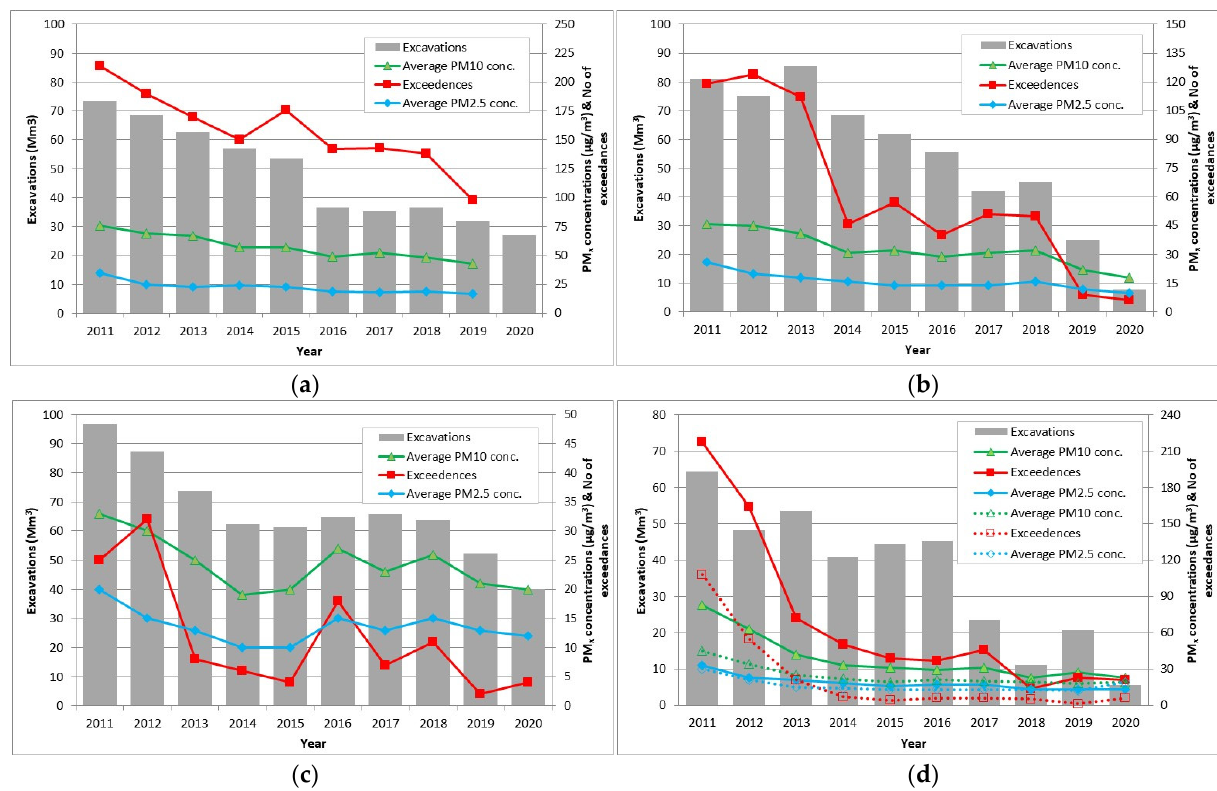
Figure 1. Annual variations of total rock excavations in four different lignite mining fields of the Ptolemaida basin, average PM10 and PM2.5 concentrations and number of exceedances of the daily average PM10 concentrations from the limit value of 50 μ g/m 3 as recorded in monitoring stations (MS) located in the vicinity of the mines: ( a ) Main Field vs. Proastio MS; ( b ) Kardia Field vs. Pontokomi MS; ( c ) South Field vs. Kilada MS; ( d ) Amynteo mine vs. Anargiri MS (solid line) and Amynteo MS (dashed line).